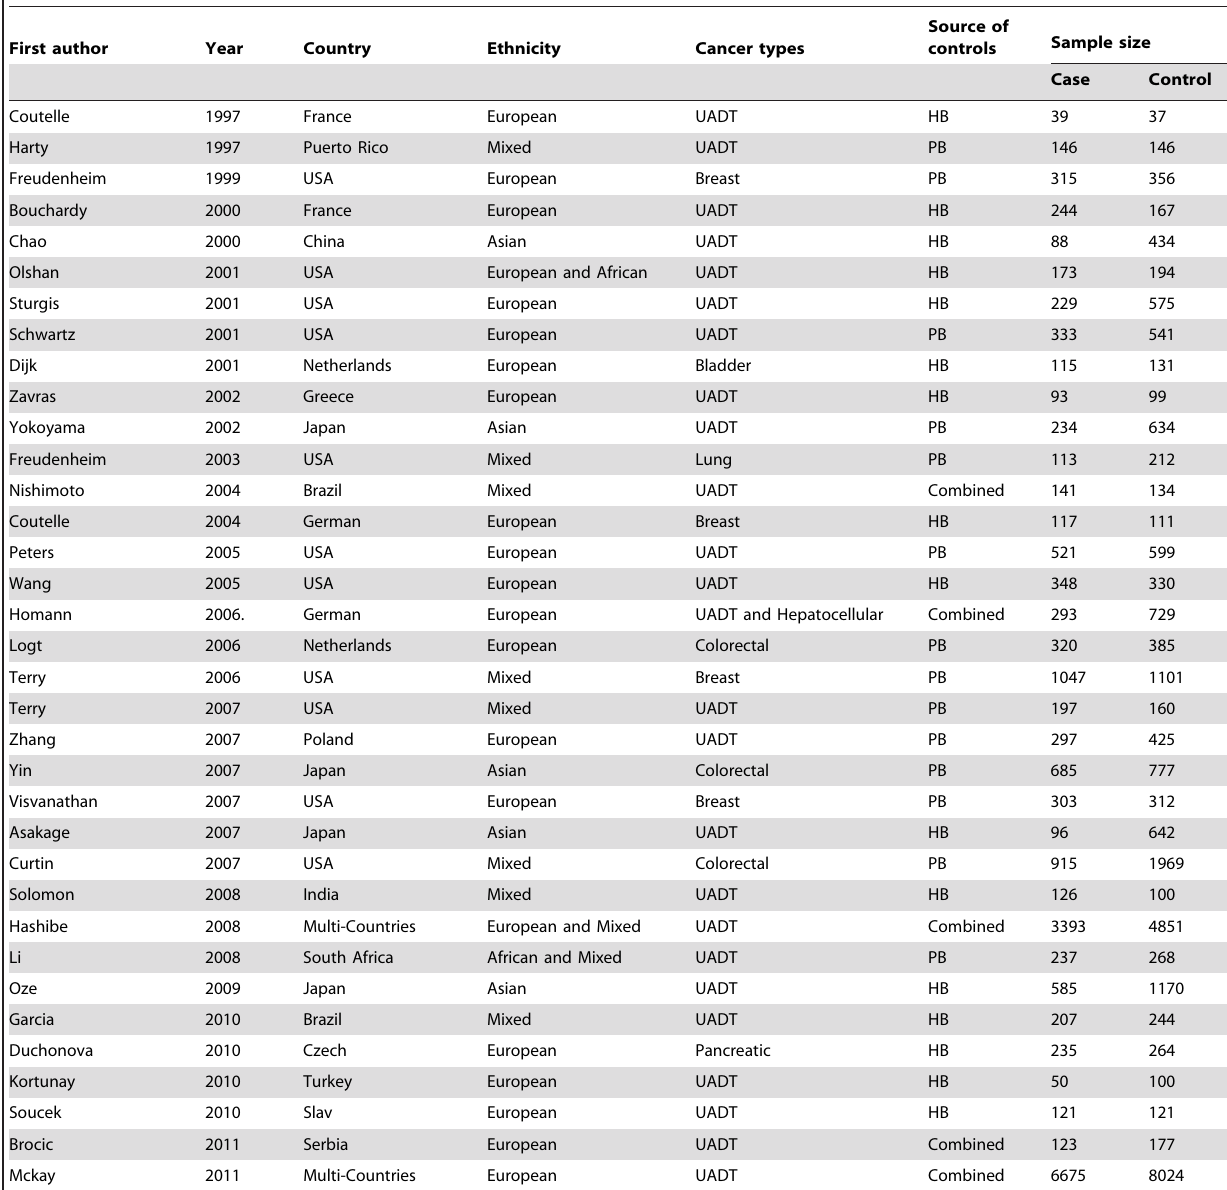
Table 1. Characteristics of studies included in the